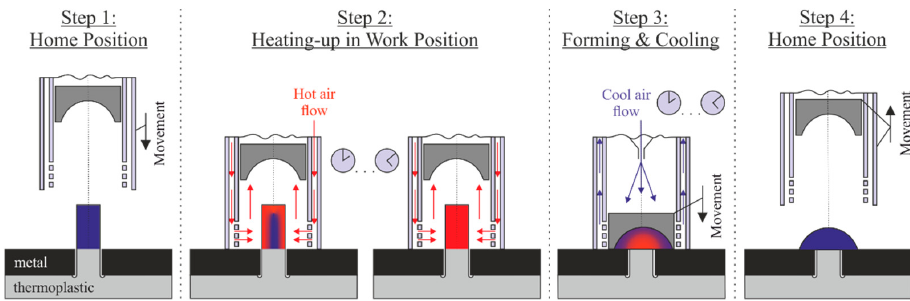
Figure 2. Schematic illustration of the hot air staking process consisting of four process steps.